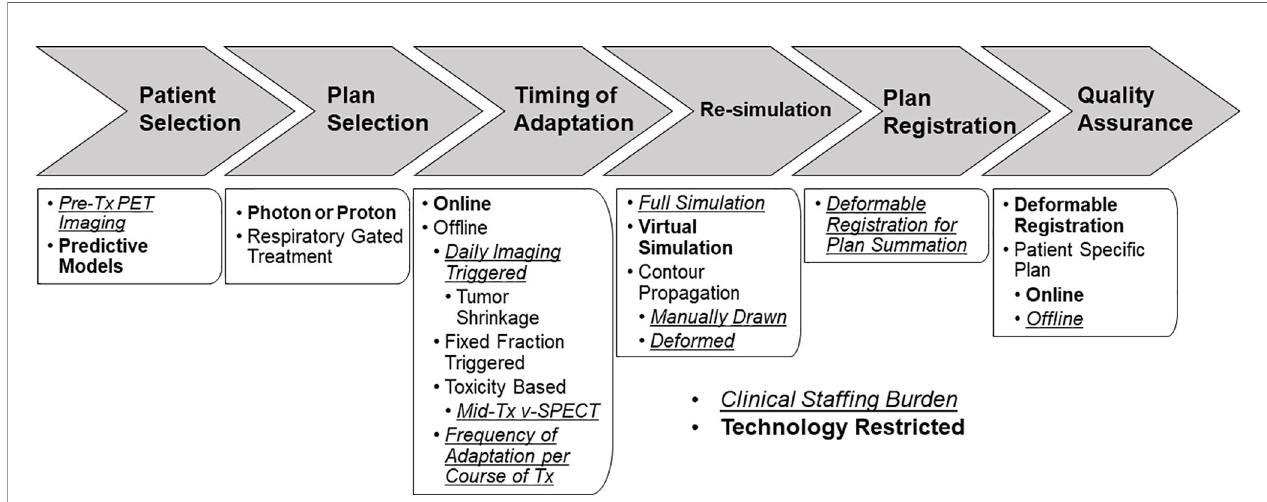
FIGURE 1 | ART work fl ow for lung cancer patients highlighting diverging work fl ow, decision points, technology restrictions (bold text), and additional staf fi ng burden (italic/underlined